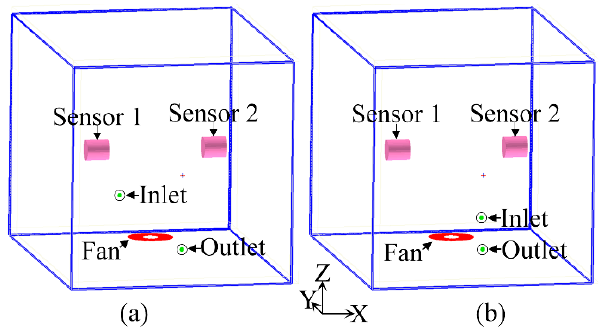
Figure 6. Physical models of ( a ) type I closed box and ( b ) type II closed box. Table 1. Simulation